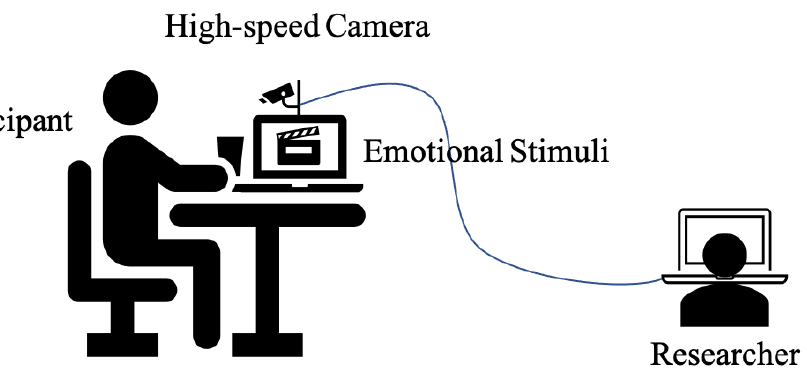
Figure 13. For the purposes of data collection, participants watch an emotional video while their faces are imaged by high-speed